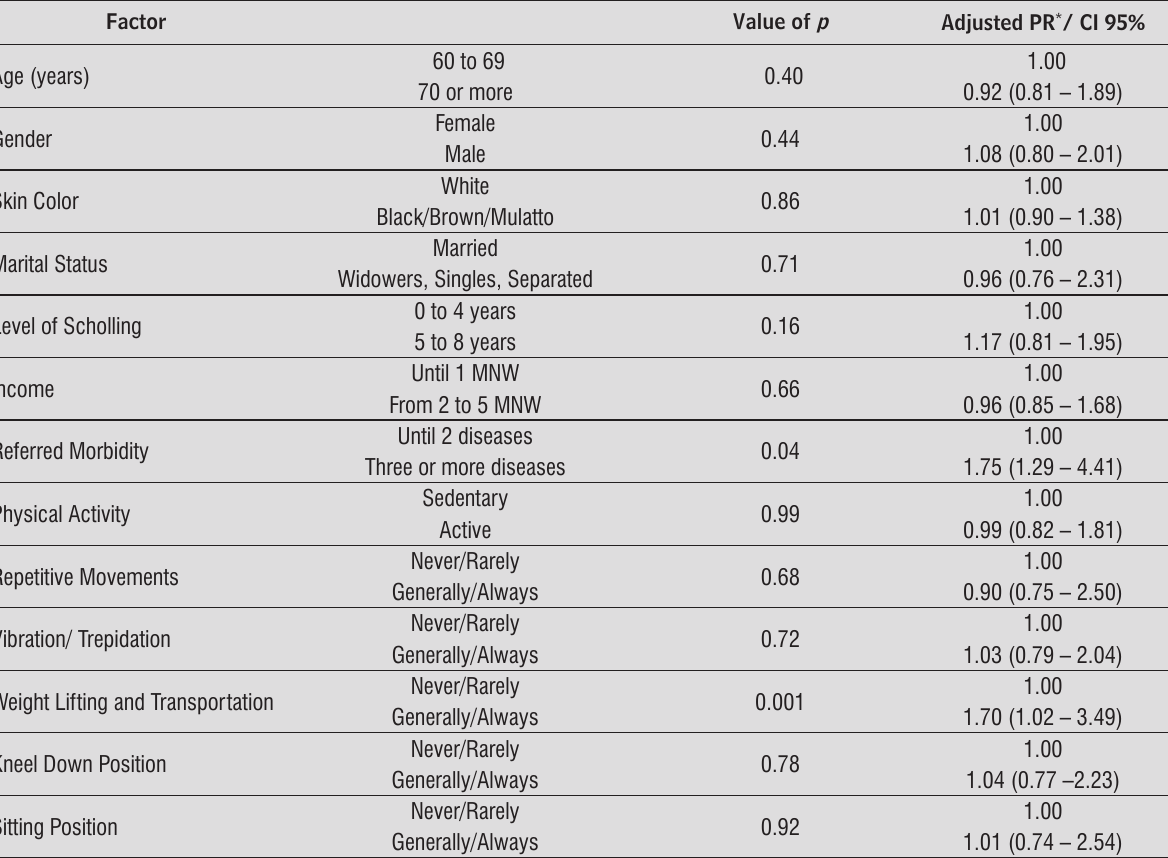
Table 5 - Poisson’s regression analysis for low back pain in elderly